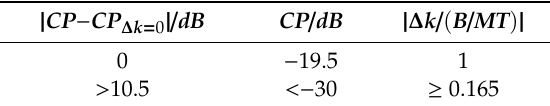
Table 2. CP values with ∆ k .